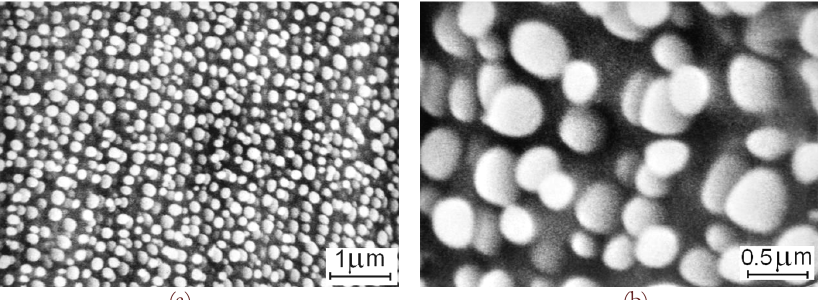
Figure 3: Typical microstructure of EI698 with gamma prime phase (  ’) under (a), (b) different magnification in electron microscope. Non-destructive inspection